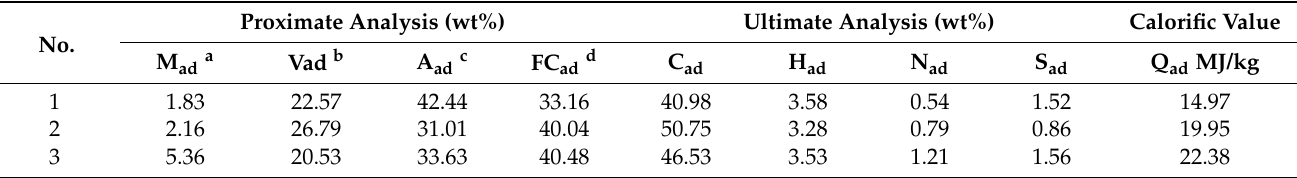
Table 2. Proximate analyses and ultimate analyses of coal feed in the furnace.